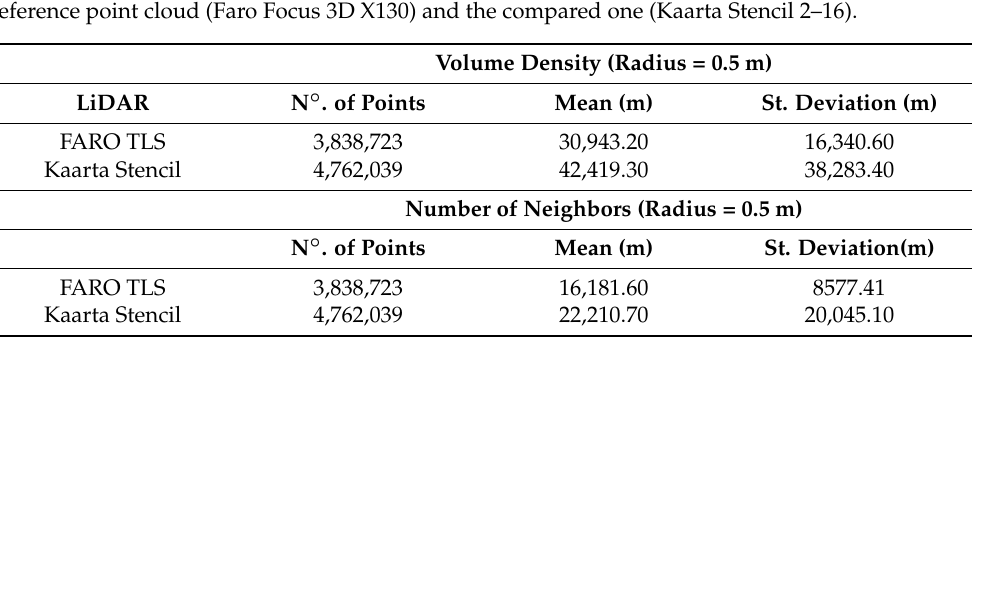
Table 5. Volume density and number of neighbors comparison in a volume of 1 m 3 between